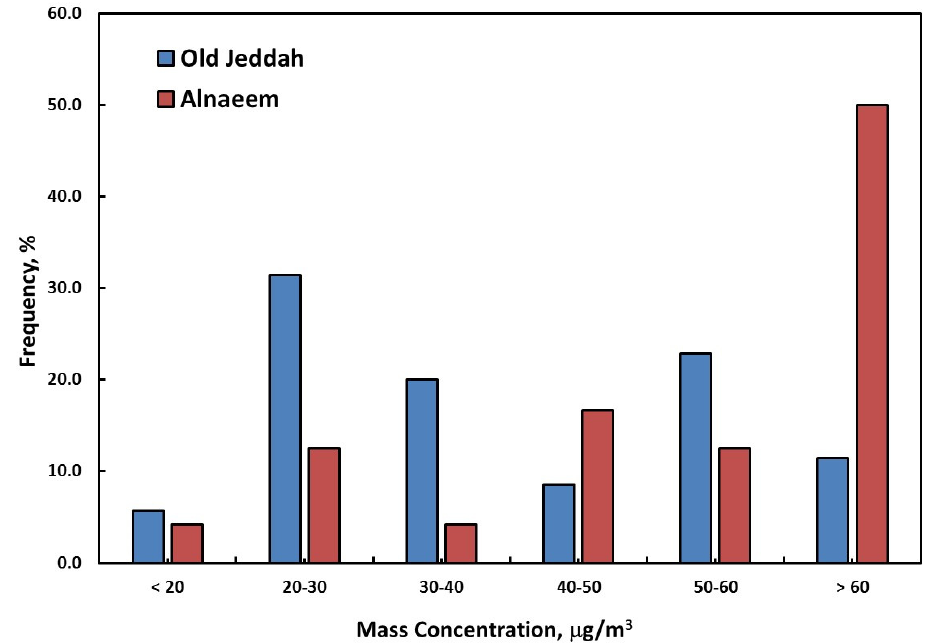
Figure 4. The frequency percentages of the daily mass concentration of the PM 2.5 samples collected from the historical Jeddah and Alnaeem districts in Jeddah, Saudi Arabia.